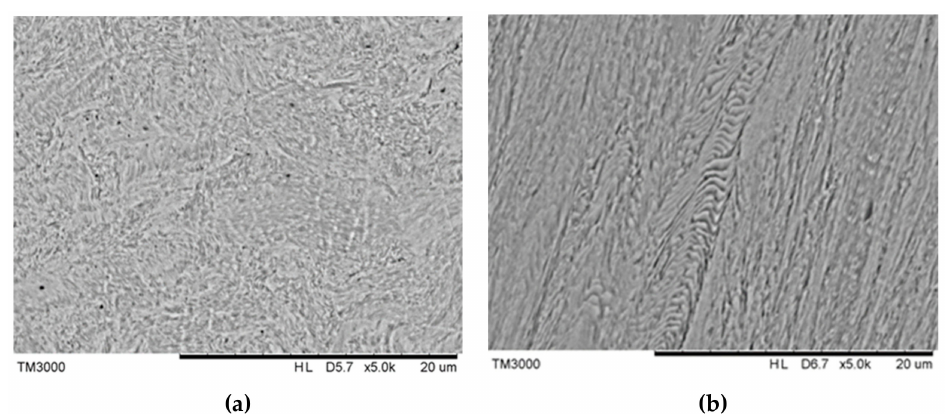
Figure 5. ( a ) Microstructure on cross-sectional direction, and ( b ) longitudinal